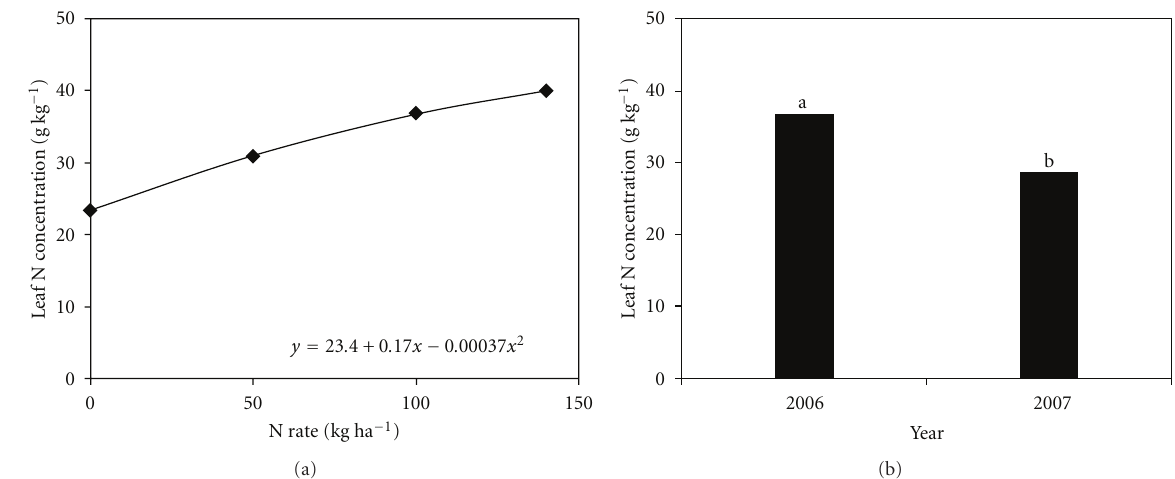
Figure 3: Leaf N concentration at early bloom as a ff ected by (a) N rate (averaged across years and rye residue management) and (b) year (averaged across rye residue management and N rates). Columns followed by di ff erent letters are significantly di ff erent ( P ≤ 0 . 05).